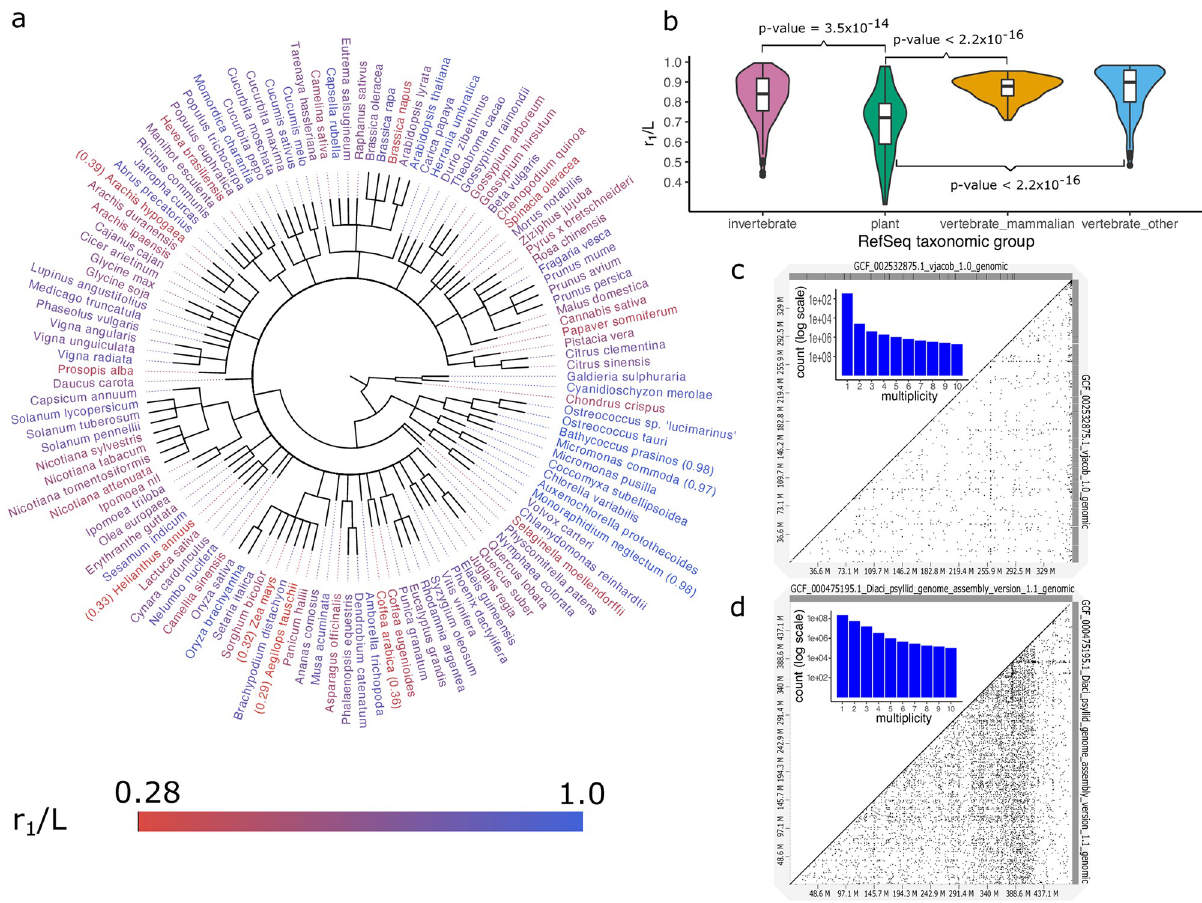
Fig 1. Characterizing repeats at k-mer level. A: RefSeq plant taxonomy. The species are color-coded based on the uniqueness ratio, from red (highly repetitive) to blue (non-repetitive). B: Uniqueness ratio distribution among four major taxonomic groups of eukaryotes in RefSeq. Plants (green) have significantly lower r 1/ L compared to invertebrates (pink), mammals (yellow), and other vertebrates (blue). P-values shown on the figure, are the result of statistical tests that the uniqueness ratio is lower among plants compared to other groups. Also, to understand the extent of difference, we tested if the ratios are lower among plants by X % margin. The results are 5% p-value = 1.1 × 10 − 6 , 10% p-value = 4.3 × 10 − 6 , and 10% p-value = 4.2 × 10 − 6 when comparing plants against invertebrates, mammals, and other vertebrates, respectively. C: Dot-plot of V. jocobsoni genome’s (self)alignment with very few off-diagonal points, and a rapidly decaying repeat spectrum ( r 1 / L = 0.99). D: Dot-plot of D. citri ’s highly-repetitive genome marked by many off- diagonal elements and a smoothly decreasing repeat spectrum ( r 1 / L =